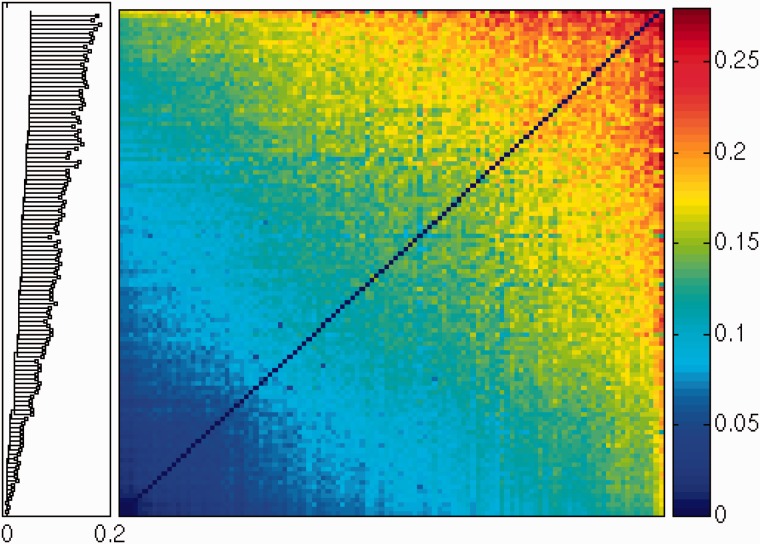
Distance matrix of 113 processed pseudogenes of the RPL21 gene and their phylogenetic tree. The rows and the columns of the distance matrix are sorted with respect to their average. The resulting order is used to constrain the topology of the phylogenetic tree (see Materials and Methods for details).